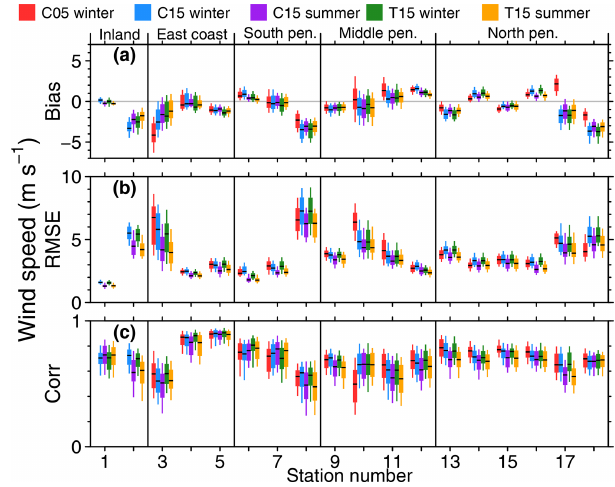
Figure 8. As Fig. 7 but for 10m wind speed.